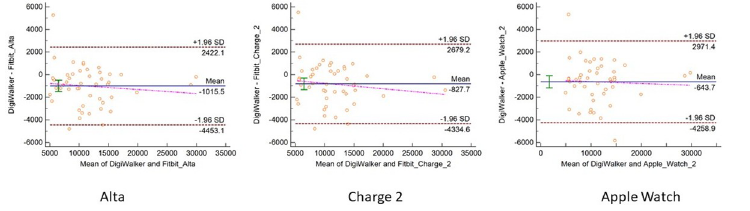
Fig 2. Bland-Altman plots comparing steps between Yamax and research and consumer activity monitors.